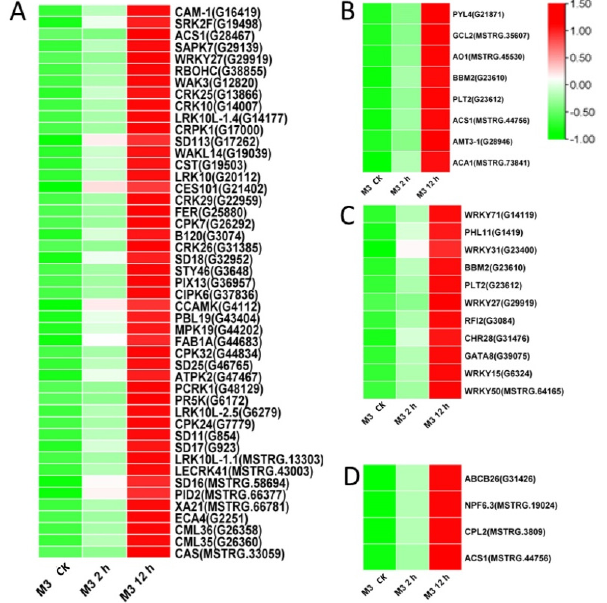
Figure 8. Heatmap of DEGs unique to M3 plants involved in Profile 7 in M3 plants. ( A ) Protein kinase and Ca 2+ signal-related genes, ( B ) hormone-related genes, ( C ) transcription factors, and ( D ) stress-related genes were identified. The sample and treatments are displayed at the bottom of each column. Relative expression levels are shown by a colored gradient, from low (green) to high (red). Scale bars represent the log 2 transformations of the RPKM values.